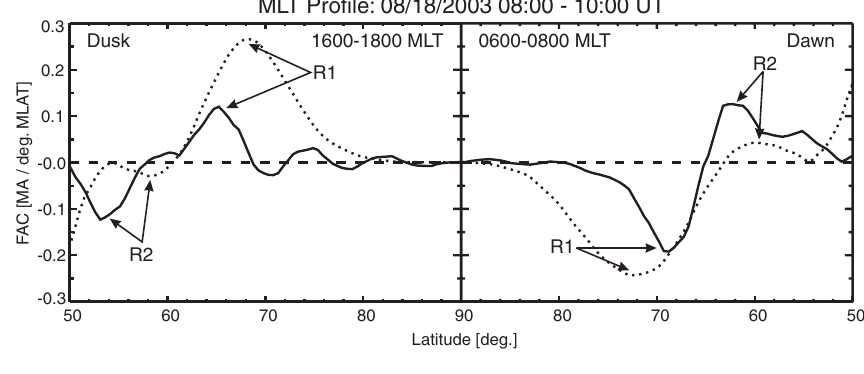
Fig. 3. Differential total field-aligned currents from Iridium (solid line) and LFM simulation (dotted line) at dawn and dusk for 18 August 2003,